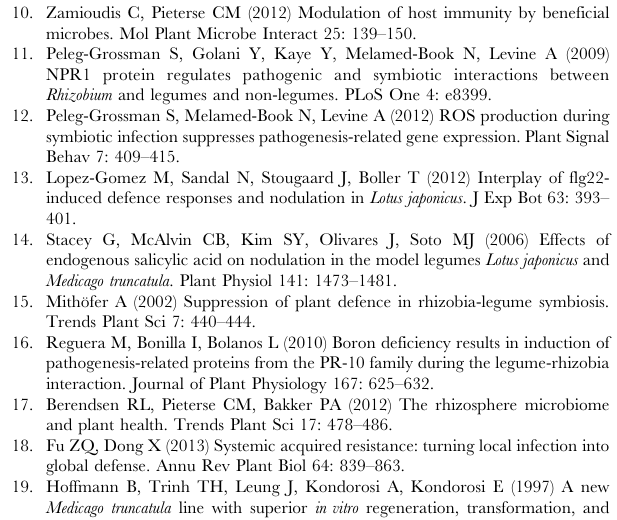
(21 dpi) induced by S. medicae strain WSM419. Data were normalized with MtACTIN expression and reported to the expression in WT nodules developed in the same conditions. Figure S2 Plant growth conditions effect on dnf2 plants is reversible. (a–e) Frequencies of nodule classes after transfer to agar or agarose media. M. truncatula dnf2–4 and WT plants (n= 24 for every conditions) inoculated with S. meliloti Rm41 were cultivated in vitro on BNM using either agar or agarose as a gelling agent for 14 days and transfer to new medium with the same or a different gelling agent. Pink nodules are represented by diamonds, white nodules by open squares and brownish nodules by triangles. The experiment has been repeated three times with similar results. (f) % of nodule classes at 35 days after transfer. Figure S3 Plant substrates effect on dnf2 can act at distance. M. truncatula R108 and dnf2–4 plants (n= 24 plants for every condition) nodulated with S. meliloti Rm41 were grown on agarose based BNM. Agar- or agarose-based BNM plugs (1.5 6 1 6 0.5 cm) were laid onto root systems of the plants 15 dpi. The y-axis represents the % of nodule classes. Abscises represent days after addition of the plug. The experiment has been repeated three times with similar results. Figure S4 Gelling agents do not alter WT nitrogen fixation capacity. Acetylene reduction assays were conducted on M. truncatula WT R108 plants cultivated on BNM solidified with the indicated gelling agents, 21 dpi with S. medicae WSM419. A Kruskal-Wallis one-way ANOVA test did not show significant differences between conditions (p-value = 0.3349). Figure S5 DNF2 expression is not controlled by DNF2 requirement conditions. DNF2 expression level and expres- sion pattern were investigated in nodules of M. truncatula WT R108 (A) plants or transgenic WT pDNF2::Gus (B,C). The plants were cultivated on BNM solidified with the indicated agent and DNF2 expression level was followed by RT-qPCR using Actin as a reference (A). Results are expressed as ratio versus expression on Phytagel based BNM. Error bars represent the standard error on three biological repetitions. Transgenic plants expressing the